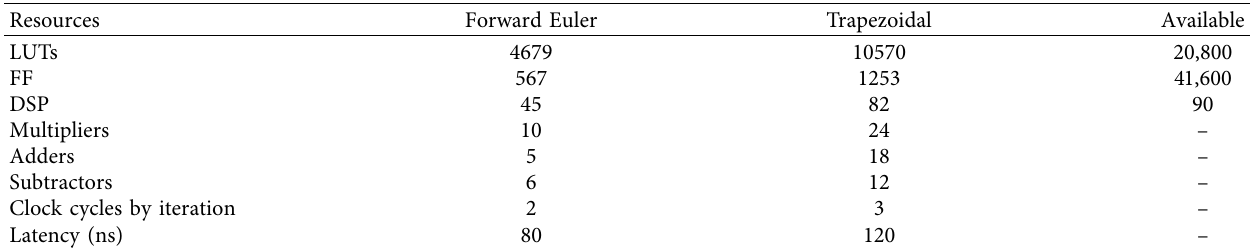
Figure 34: Block diagram of the discretization of the proposed model (1) using the forward Euler method. Table 1: Hardware resources for the FPGA design of (1) using the FPGA basys 3 xilinx artix-7 XC7A35T-ICPG236C using two numerical methods with h � 0 . 001.